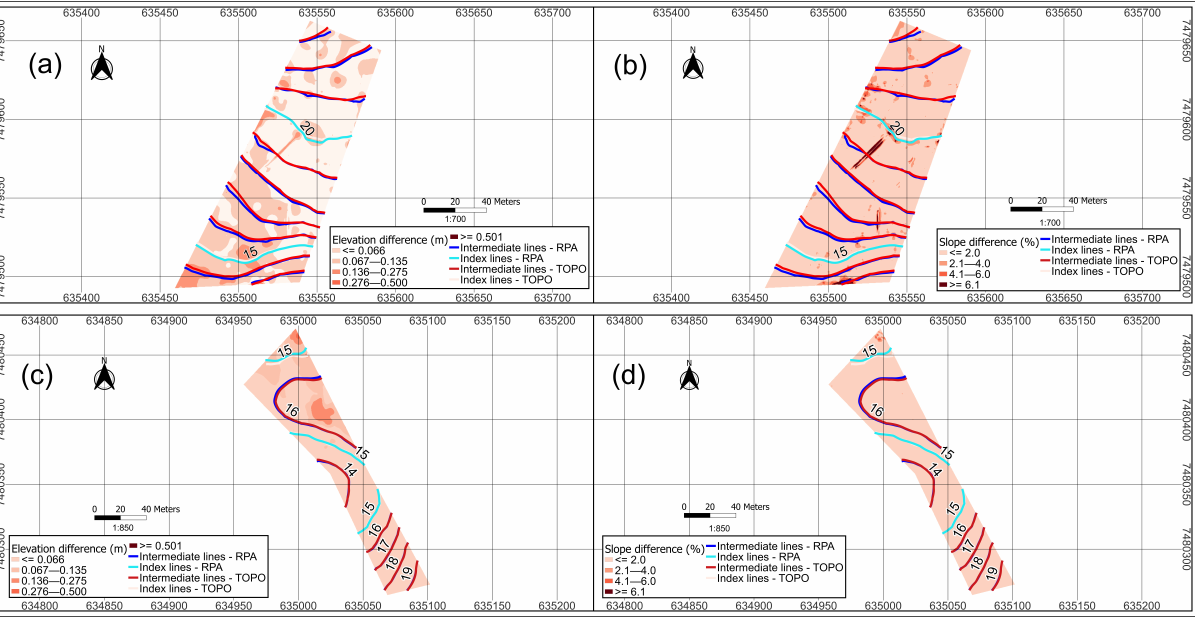
Figure 17. Superposition of homologous contour lines from topography and RPA of areas 3 and 4 over elevation and slope difference maps: ( a ) superposition of contour lines over DEM differences of area 3, ( b ) superposition of contour lines over slope differences of area 3, ( c ) superposition of contour lines over DEM differences of area 4, ( d ) superposition of contour lines over slope differences of area